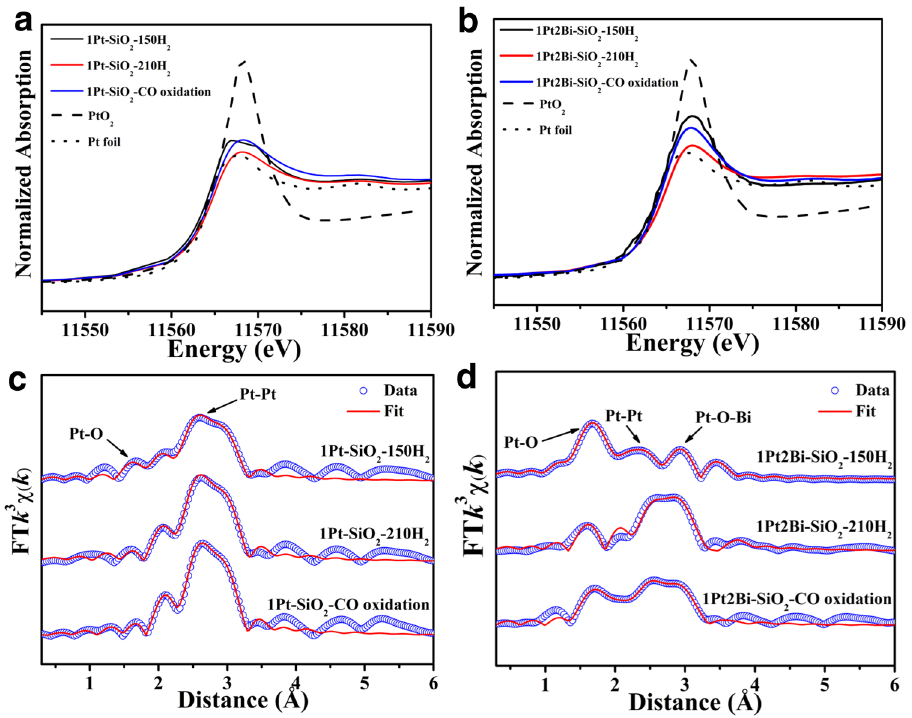
Fig. 5 The local coordination structure of Pt/PtBi – SiO 2 catalysts. Quasi in-situ Pt L 3 – edge a , c XANES pro fi les and b , d EXAFS fi tting results in R space for 1Pt-SiO 2 ( a , b ) and 1Pt2Bi-SiO 2 ( c , d ) under speci fi c conditions.